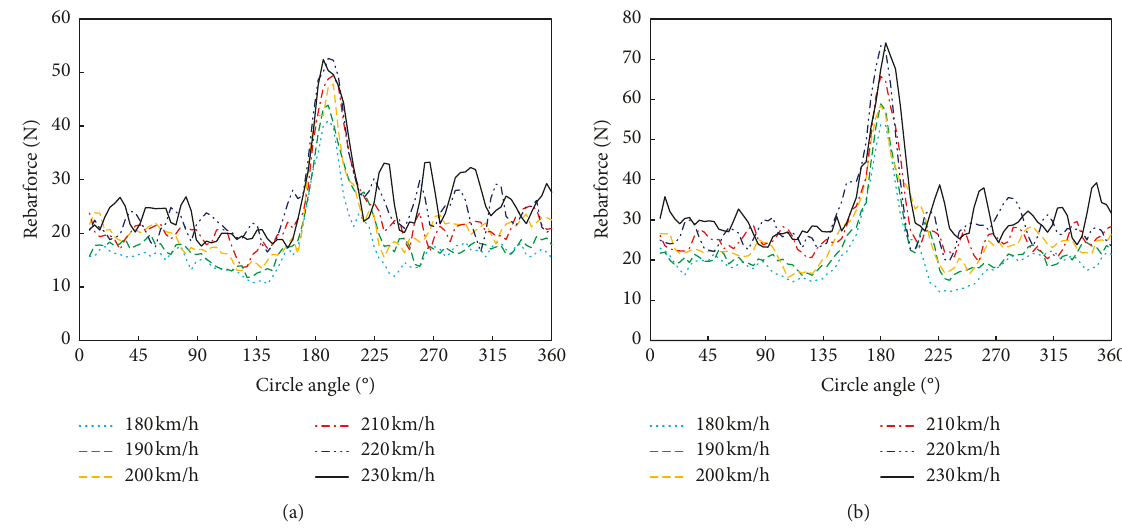
Figure 12: Circumferential stress on belt cord ends at different velocities. (a) Circumferential stress on the cord end of the first belt layer (point C). (b) Circumferential stress on the cord end of the second belt layer (point